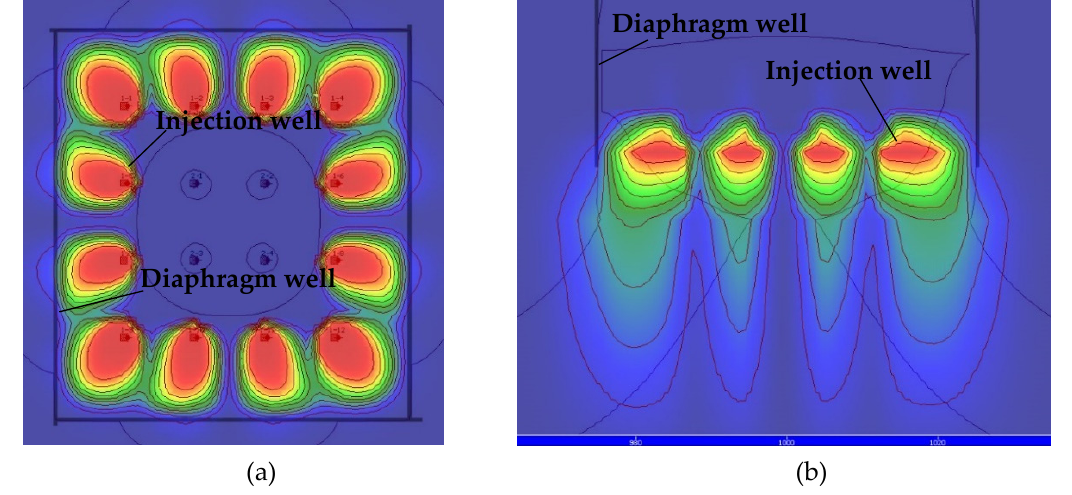
Figure 13. Migration of S. pasteurii after 4 days in condition 3: ( a ) Horizontal; ( b ) Vertical.